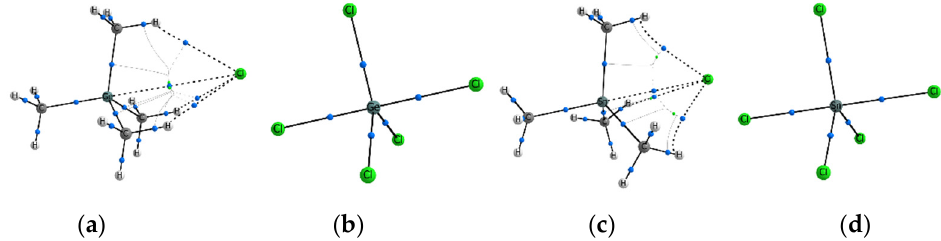
Figure 3. Weak and strong complexes ( a ) CH 3 –Ge(CH 3 ) 3 …Cl − ; ( b ) Cl–GeCl 3 …Cl – ; ( c